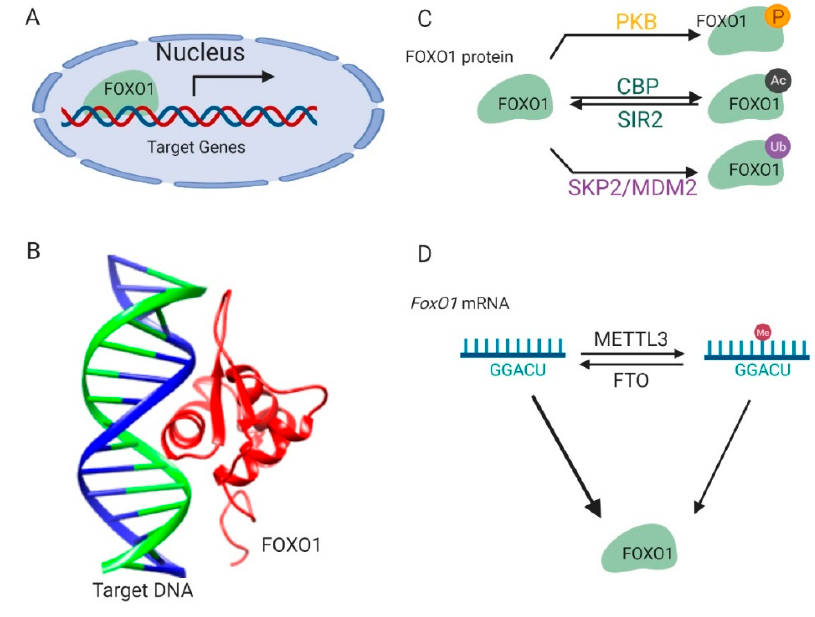
Figure 1. Regulation of FOXO1 transcription activity. ( A ) FOXO1 binds to the promoters of target genes and stimulates their transcription in nucleus. ( B ) The complex structure of the FOXO1 protein and its target-binding DNA (Protein Data Bank id: 3CO6). ( C ) The post-translational modifications of the FOXO1 protein. ( D ) Methylations on the FoxO1 mRNA regulate its expression. This figure was created with UCSF Chimera [29] and BioRender.com.